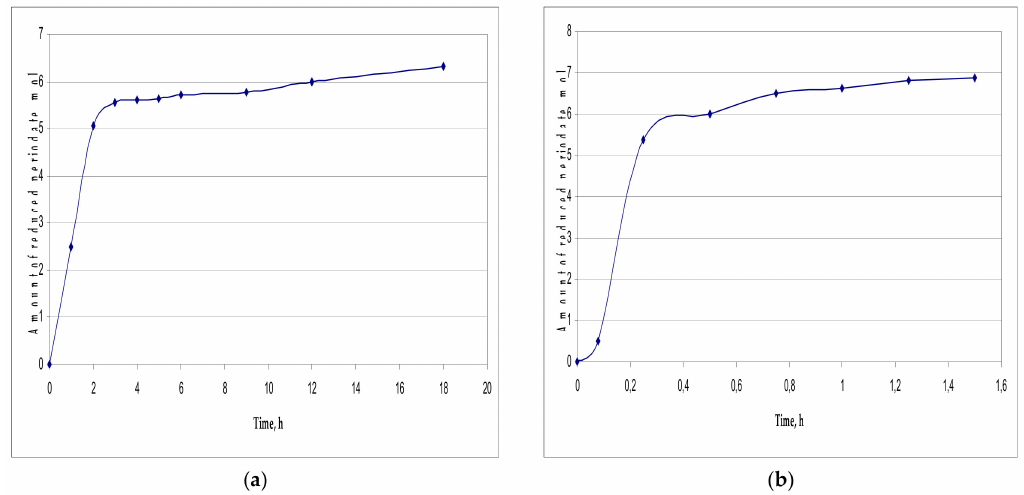
Figure 5. Consumption of NaIO 4 : ( a ) T = 45 ◦ C; t = 18 h; ( b ) T = 80 ◦ C; t = 1.5 h.